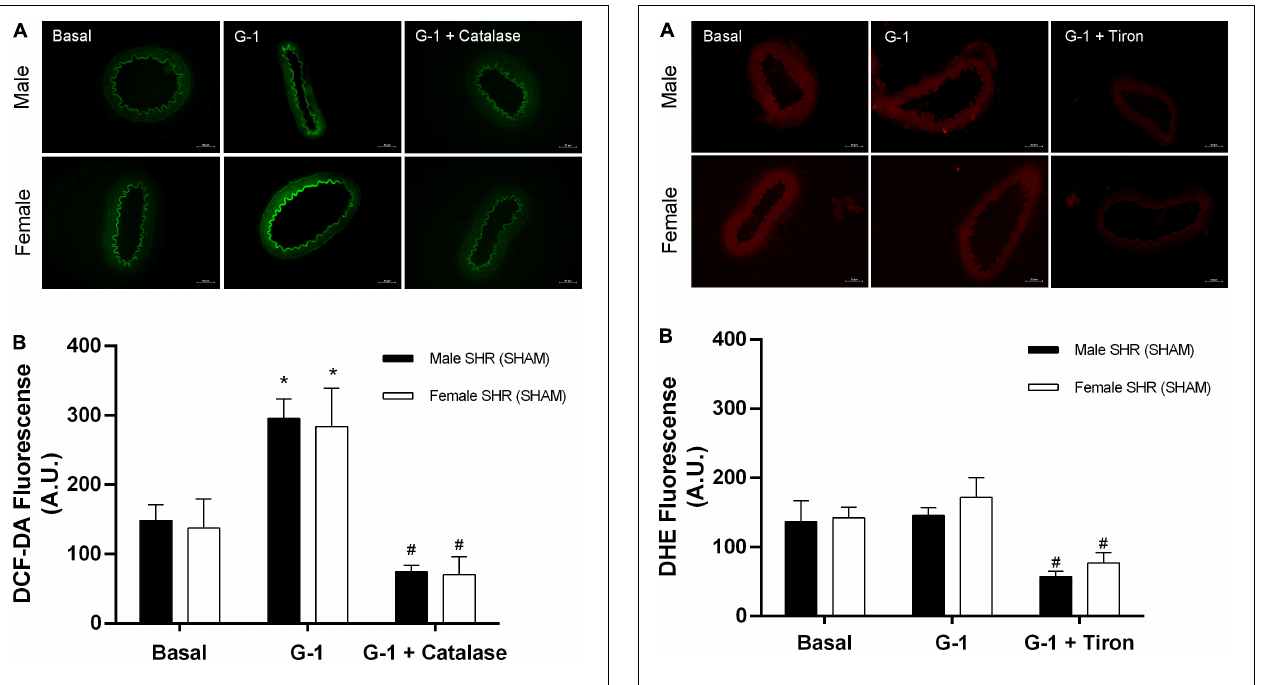
FIGURE 10 | (A) Fluorescence microscopy analysis emitted by H2DCF-DA in mesenteric resistance arteries from SHR. Protocols were performed in the absence and presence of G-1 (10 µ M) and catalase (1,000 units / mL). (B) Fluorescence analysis produced in Male ( n = 5) and Female ( n = 6) groups. Scale bar = 50 µ m. Values are expressed as mean ± SEM. * P < 0.05 compared with the basal condition of the same group and # P < 0.05 compared with G-1 stimulation of the same group. Two-way ANOVA was used for the analysis, followed by the Sidak post hoc test.